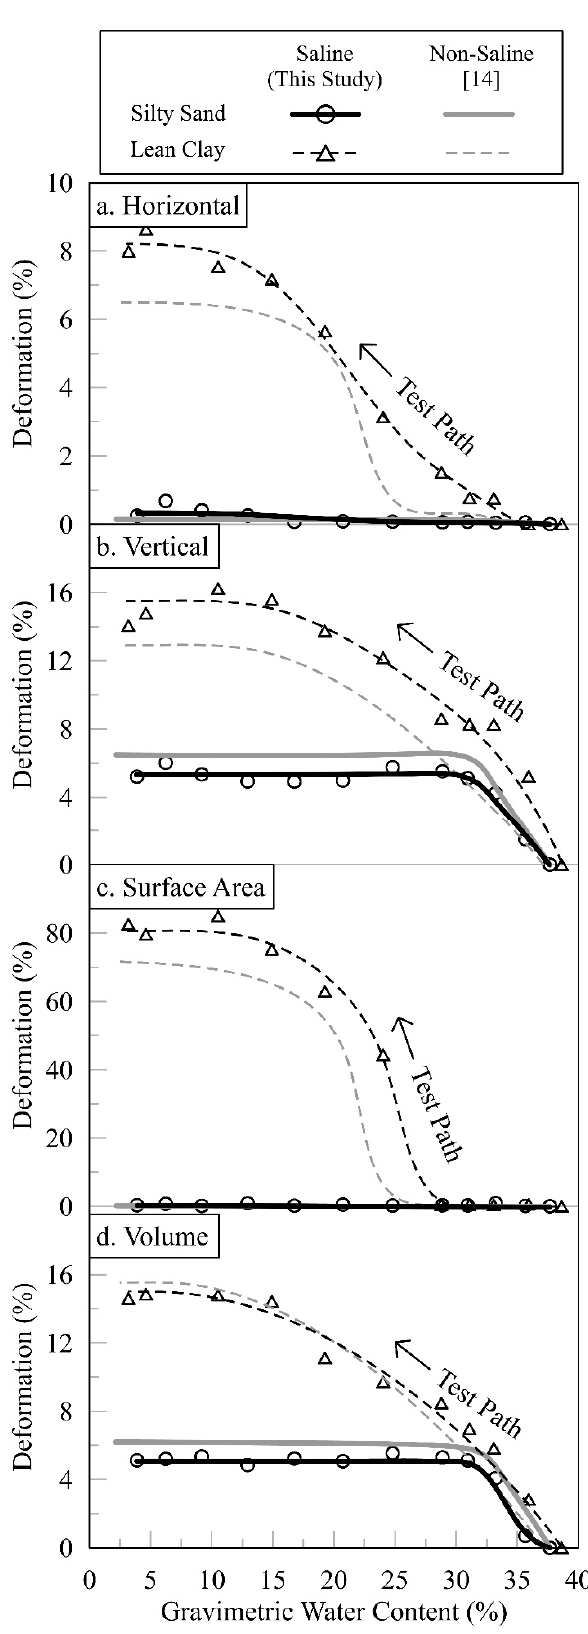
Figure 2. Deformations during drying under low demand for silty sand and lean clay: ( a ) horizontal deformation; ( b ) vertical deformation; ( c ) surface area deformation; and ( d ) volumetric deformation.